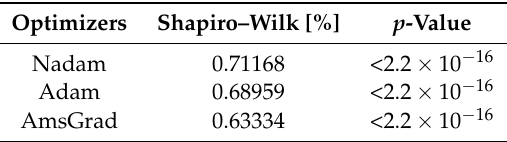
Table 4. Shapiro–Wilk normality test